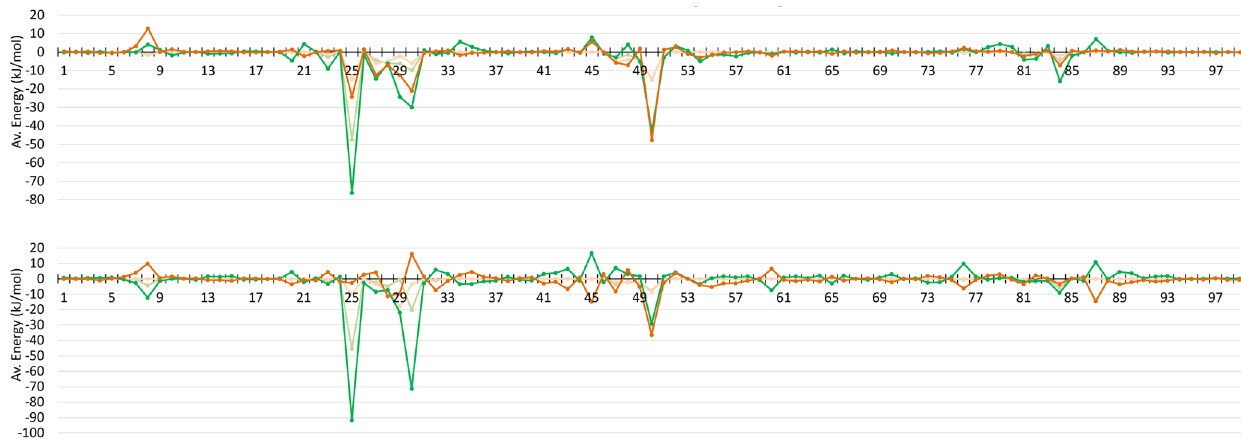
Figure 3. Averaged electrostatic interaction energies (Ees, kJ/mol) and penetration contributions to them (Epen, kJ/mol) for interactions of a ligand with each residue of a monomer for 1KZK ( top ) and 4DQB ( bottom ) structures. Ees: dark green—monomer A; dark orange—monomer B. Epen: light green—monomer A; light orange—monomer B. Analogously, for darunavir interacting with the protein, three hydrogen bonds stable over entire simulation were identified (Figure 2 bottom). These are bonds with Asp25A